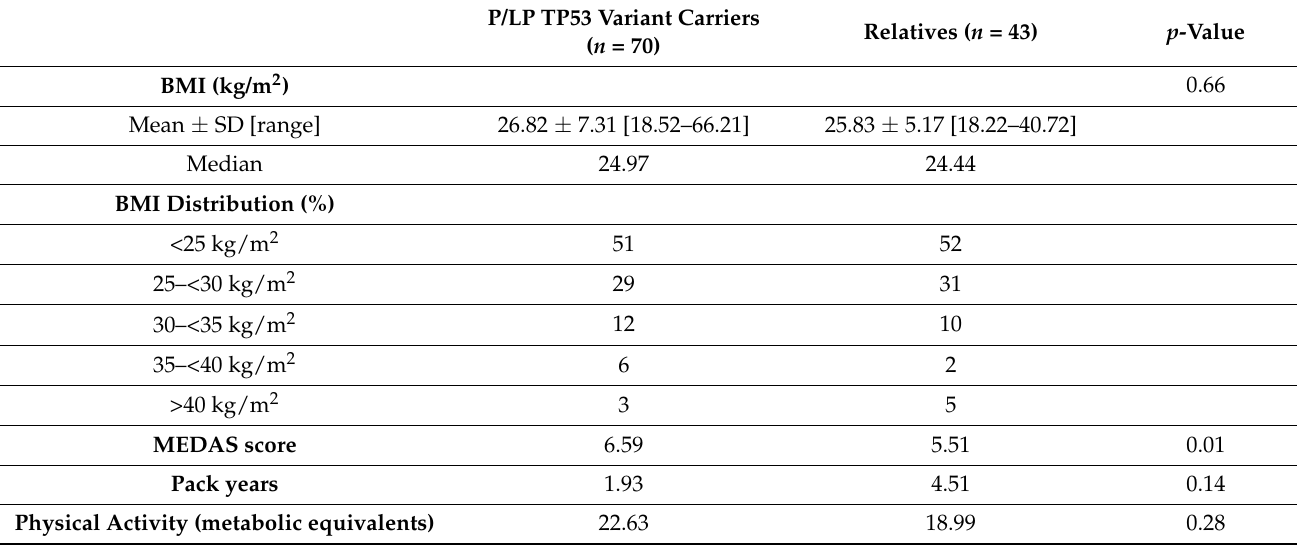
Table 2. Lifestyle and Dietary Habits, Physical Activity of people with a pathogenic/ likely pathogenic (P/LP) TP53 germline variant as well as their relatives as captured with the questionnaire. P/LP TP53 Variant Carriers Relatives ( n = 43) p -Value ( n = 70) BMI (kg/m 2 ) 0.66 Mean ± SD [range] 24.97